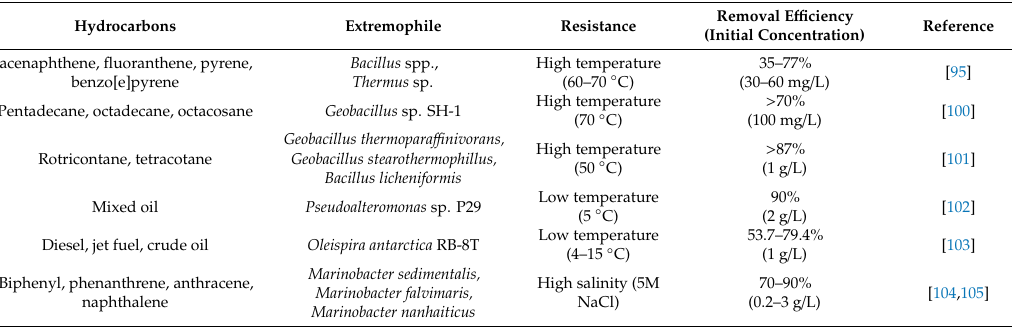
Table 2. Extremophilic microorganisms used in the removal of hydrocarbons.